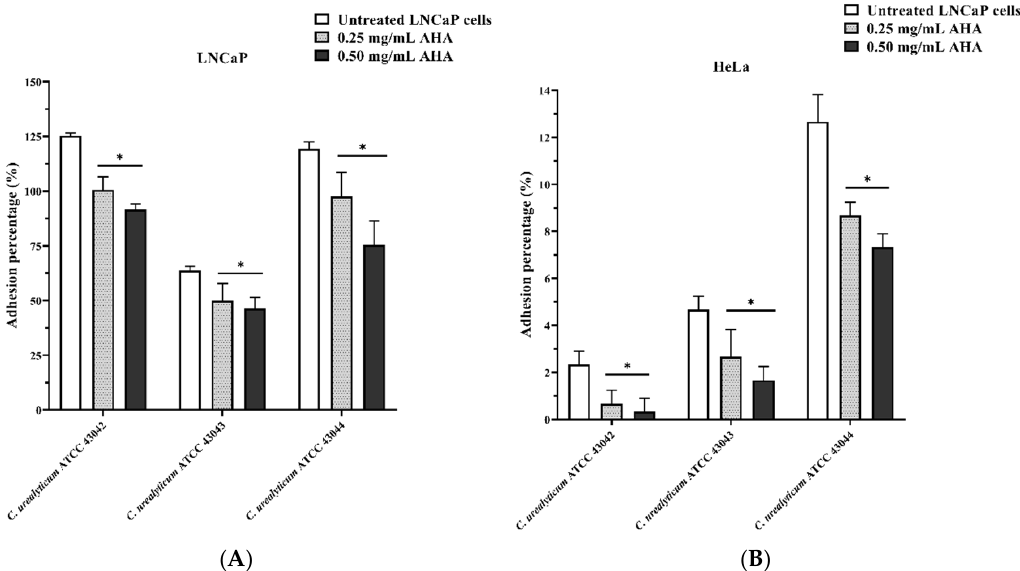
Figure 4. E ff ect of AHA on C. urealyticum adhesion to human LNCaP ( A ) and HeLa ( B ) cell lines. White histograms: strains not treated with AHA. Light grey histograms with dots: strains treated with 0.25mg/mL AHA. Black histograms: strains treated with 0.50mg/mL AHA. Results are expressed as percentage. The bars represent means ± SD of three independent experiments performed in triplicate (SD = standard deviation). Statistically significant differences, determined by two-way analysis of variance ANOVA, are indicated: * p < 0.05 versus control/untreated.